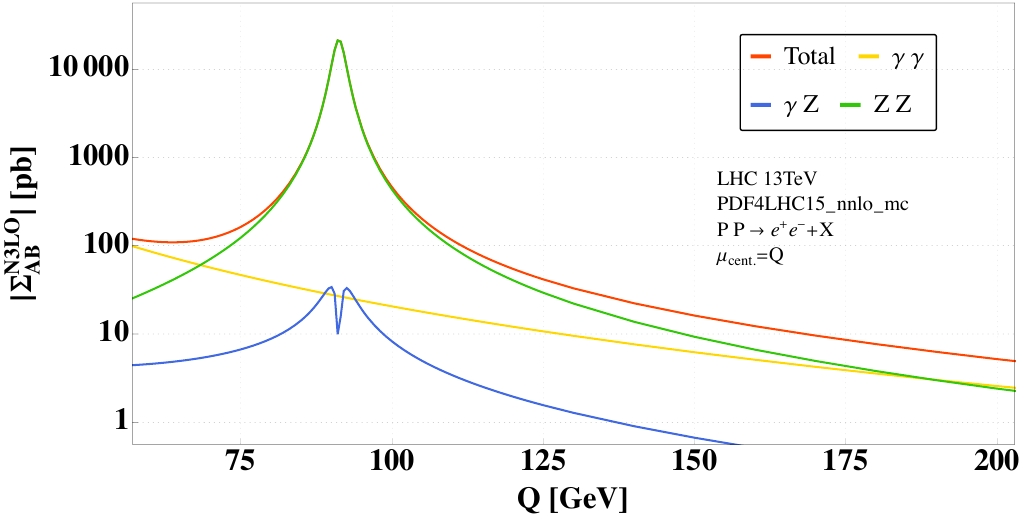
Figure 15. Decomposition of the invariant-mass distribution into the absolute value of contri- butions from photon and Z exchange and their interference as a function of Q at third order in perturbations